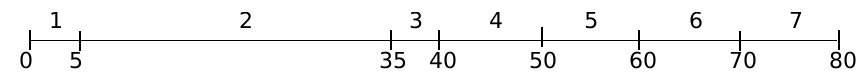
Figure 1. The initial Earliest Due date (ED)-schedule S for the problem instance of Example